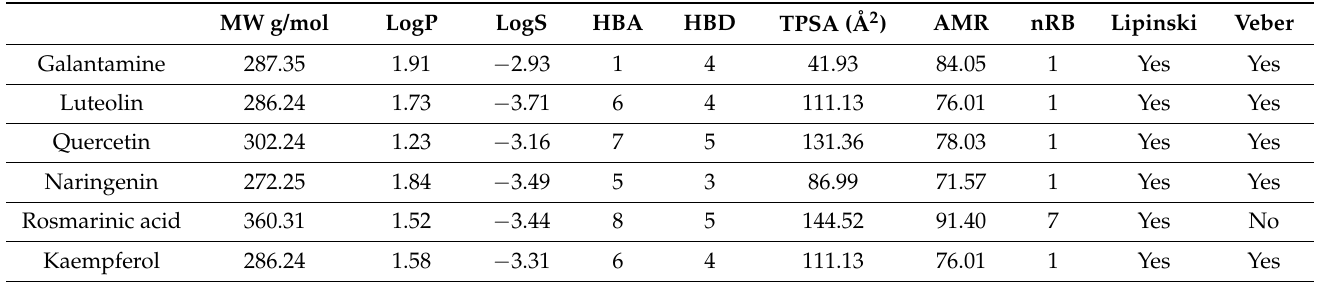
Table 5. Drug-like properties of the top active ligands of LC–MS/MS.